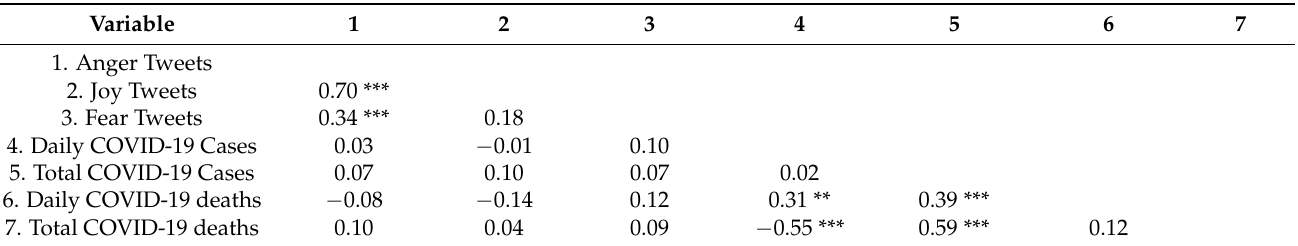
Table A6. Rome Pearson’s correlation coefficient